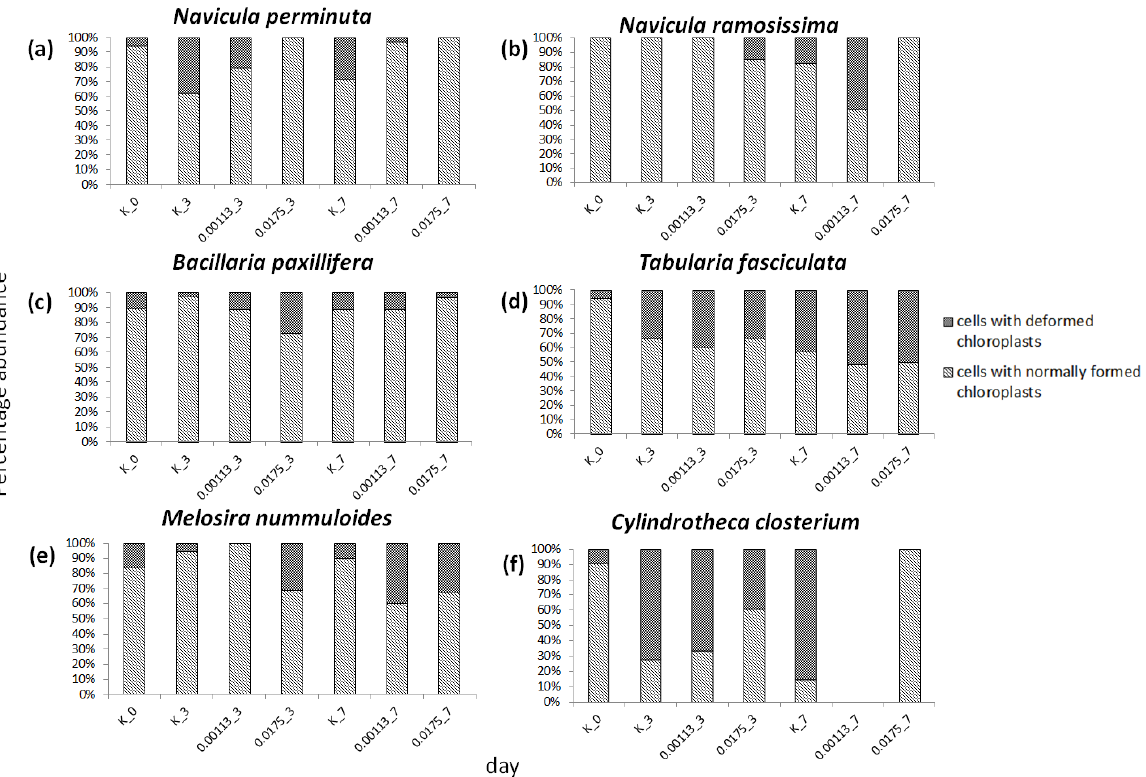
Figure 7. Condition of selected species shown as the percentage of cells with normal and abnormal chloroplasts. K indicates control cultures; 0.00113 and 0.0175 indicate cultures of lower (1.13 × 100 − 3 g·dm −3 ) and higher (1.75 × 100 − 2 g·dm −3 ) tested [BMIM]Cl concentrations, respectively. ( a – b ) — tolerant species positively affected by the ionic liquid; ( c – f ) — sensitive species negatively affected by the ionic liquid.